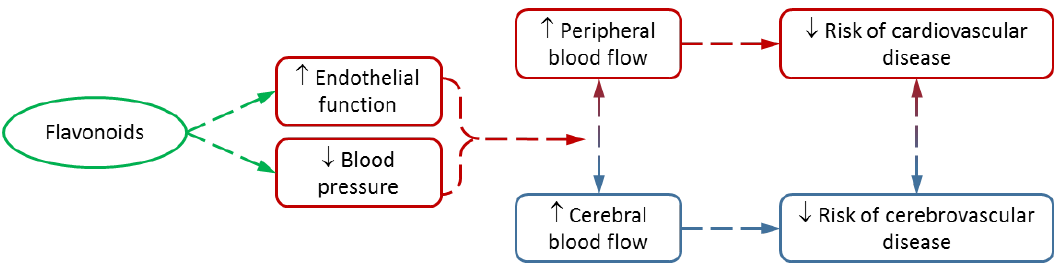
Figure 1. The effects of flavonoids on vascular and cerebrovascular function and implications for